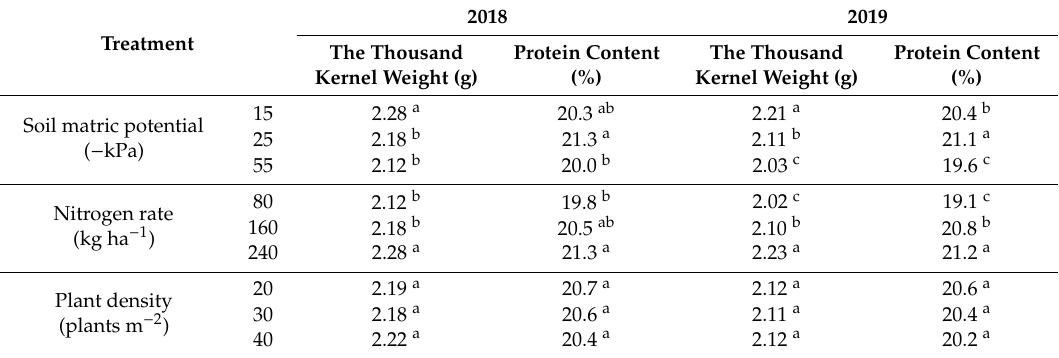
Table 6. E ff ects of soil matric potential, nitrogen application rate, and plant density on the thousand kernel weight (g) and seed protein content (%) in 2018 and